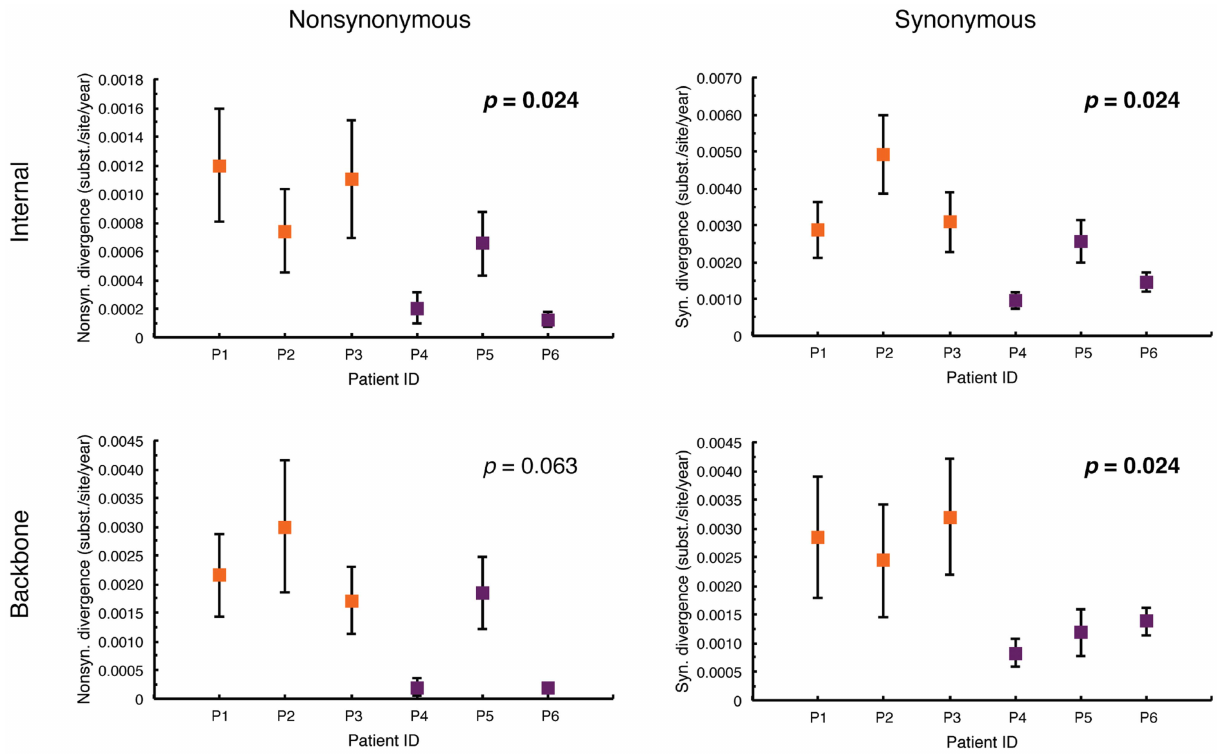
Figure 3. HIV-1 mean nonsynonymous and synonymous substitution rates for internal branches in HLA-B*5701 subjects. Subject- specific estimates were based on 200 randomly sampled trees from the posterior distribution obtained with a Bayesian coalescent framework enforcing a relaxed molecular clock. HRPs (P1-P3) and LRPs (P4-P6) are shown in orange and purple, respectively. The p -value is marked in bold when there is a significant difference between the two groups of patients. Along the y-axis, internal refers to all internal branches; backbone refers to rates averaged along all the possible backbone paths.